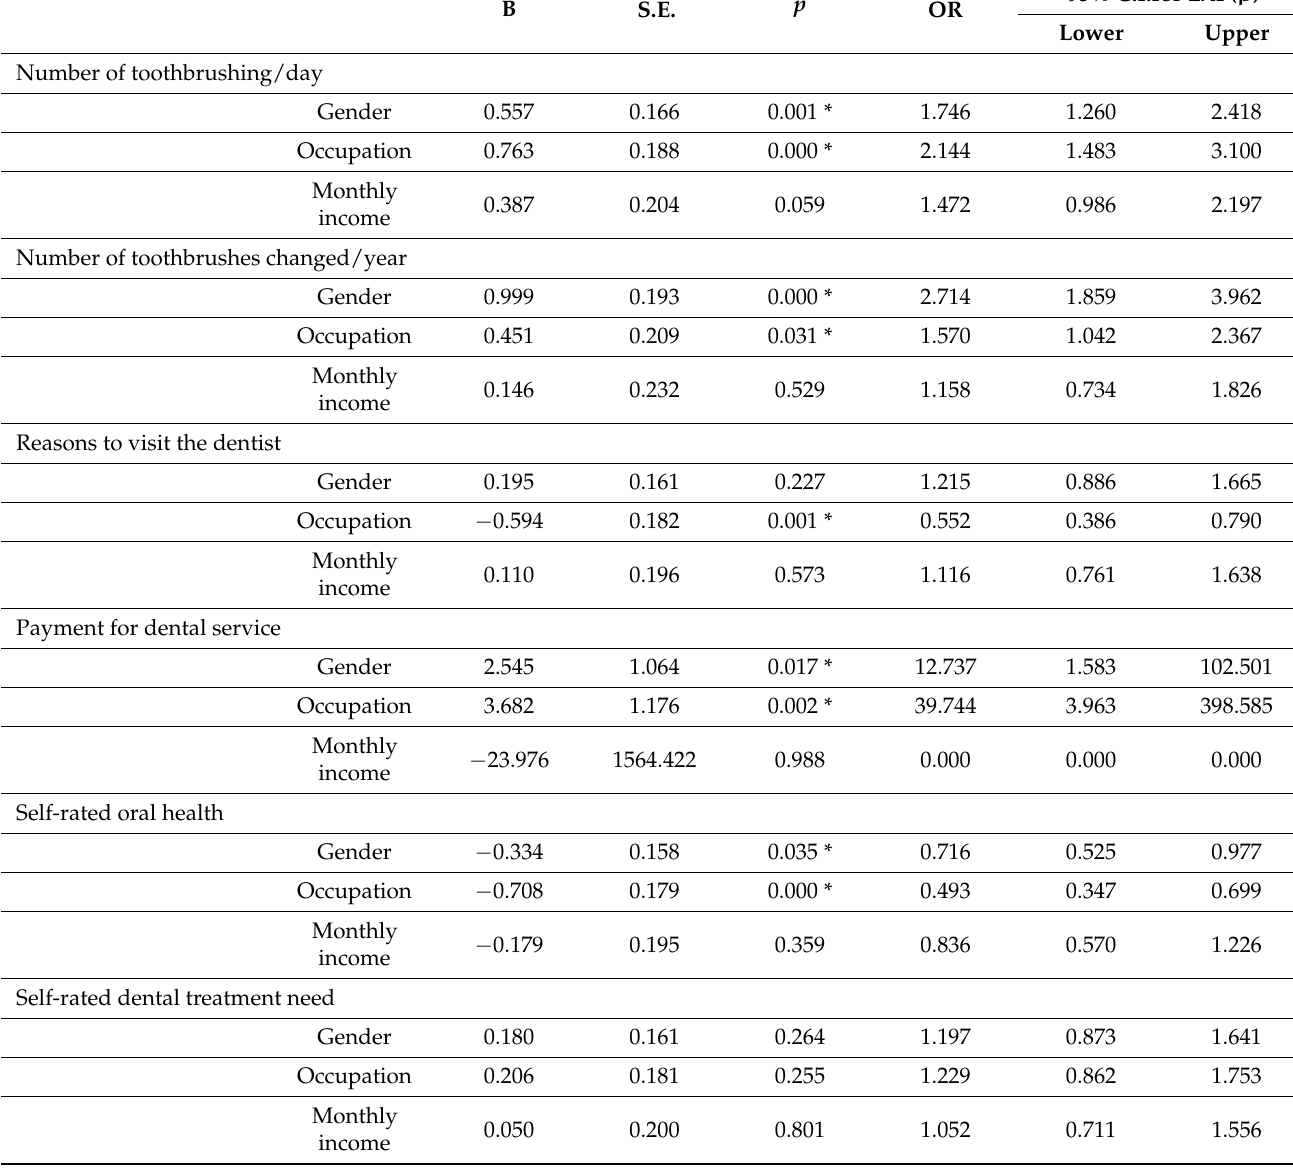
Table 4. Multivariate regression between gender, occupation, monthly income (independent vari- ables) and dependent variables that attest the access to medical services and hygiene attitudes. 95% C.I.for EXP( β ) B S.E. p OR Lower